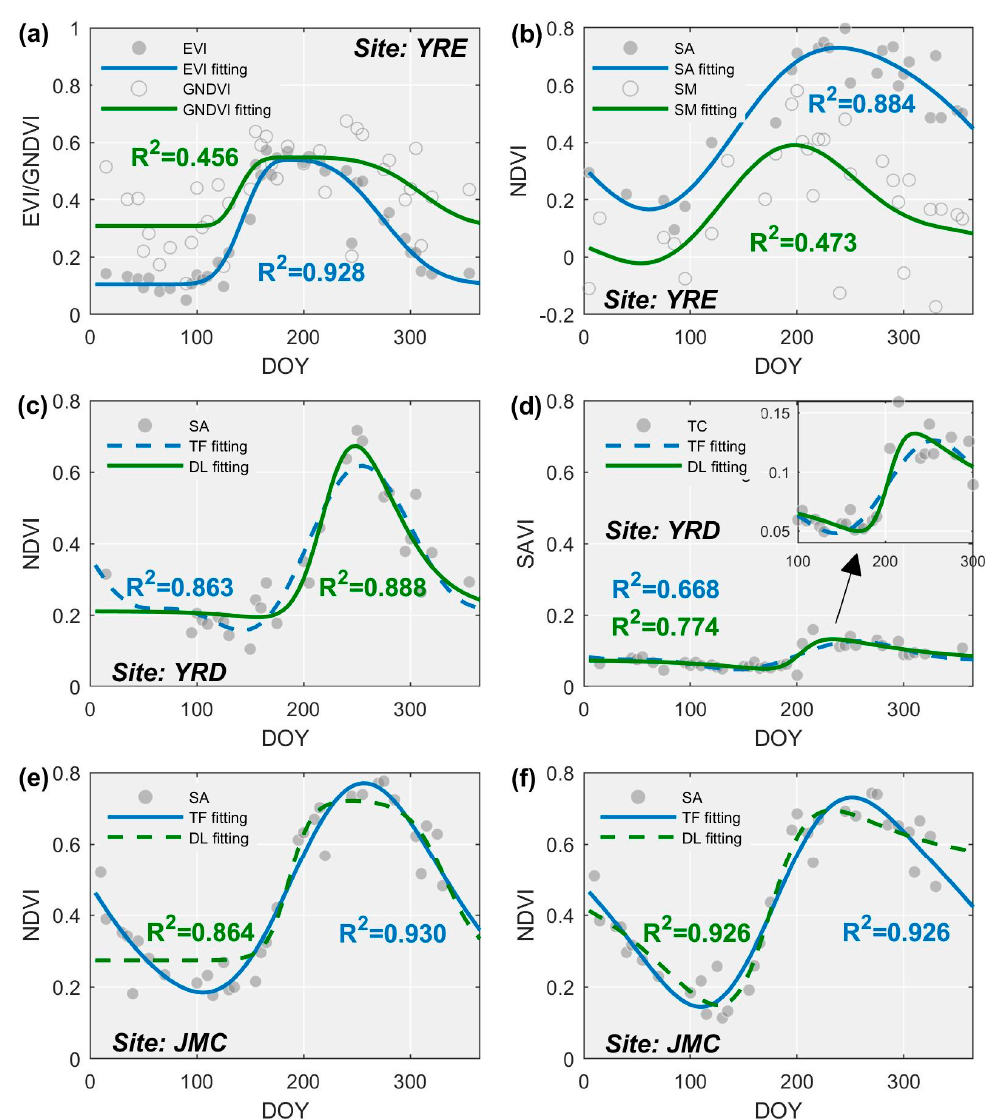
Figure 11. Impact of data distribution on curve fitting methods. ( a ) The impact of different VI time series (salt marsh vegetation: P. australis , fitting curve: AG); ( b ) the impact of different salt marsh vegetation (time series: NDVI, fitting curve: TF); ( c ) the advantage of the DL method for fitting time series in the YRD (salt marsh vegetation: S. alterniflora , time series: NDVI); ( d ) the advantage of the DL method for fitting time series of T. chinensis (time series: SAVI); ( e , f ) two examples illustrating the advance of the TF method for fitting time series in the JMC (salt marsh vegetation: S. alterniflora , time series: NDVI).